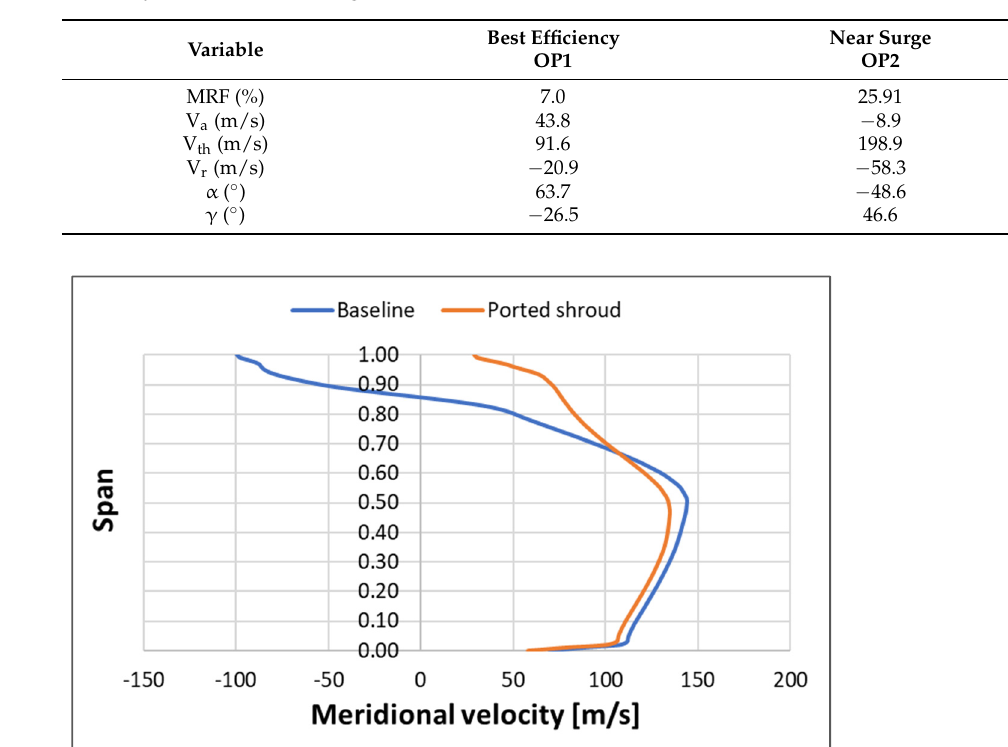
( b ) Figure 13. Contour of the relative Mach number in the meridional plane at near surge condition OP2—configurations with ported shroud ( a ) and baseline ( b ). It is clear that, in comparison to the baseline case, the recirculation zone (negative velocity) at the leading edge is eliminated in the PS case. The low momentum flow (blue color) recirculates into the cavity and it is reintroduced into the main channel in an up- stream area (see Table 3). In this zone, the two streams mix causing a re-energization of